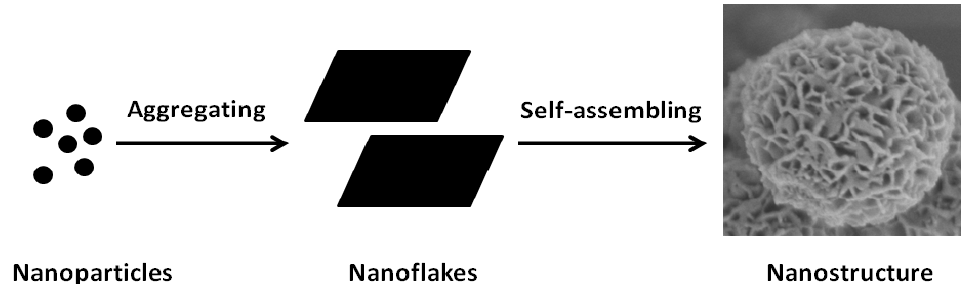
Figure 5. Proposed formation process of cobalt hydroxide